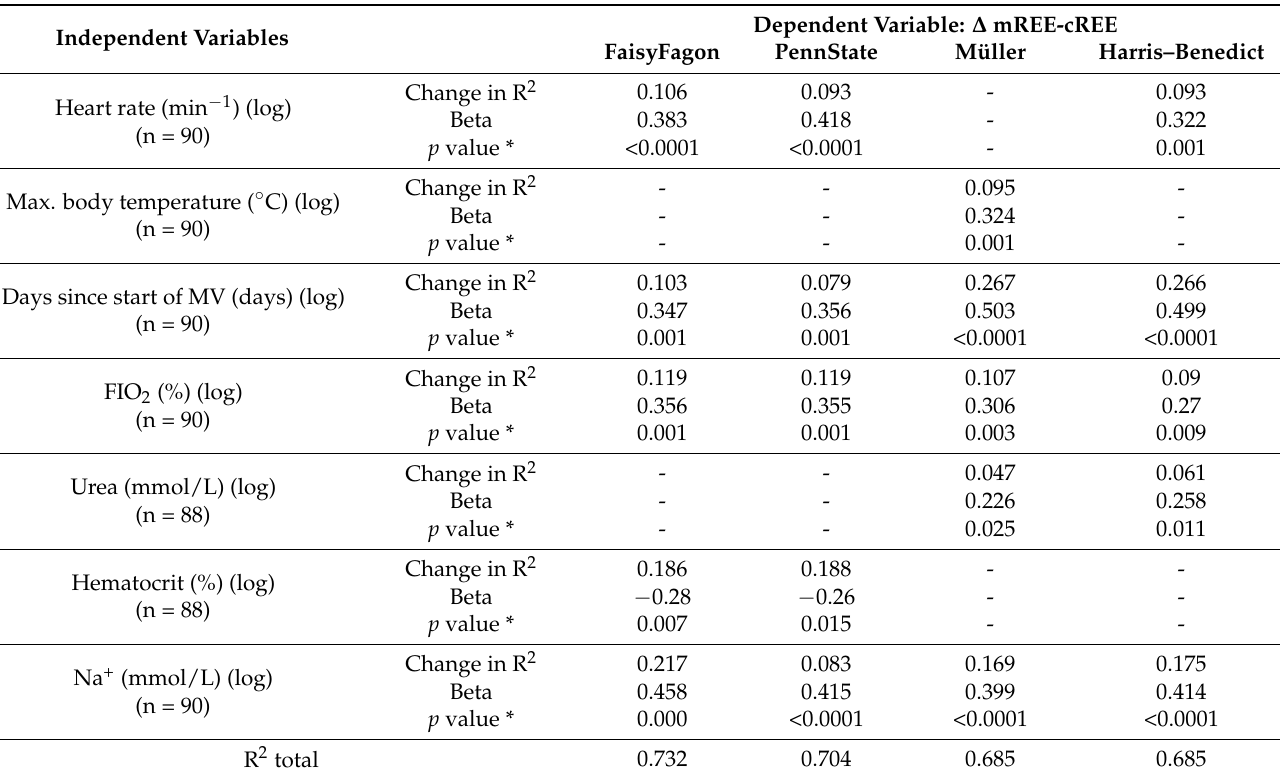
Table 3. Multivariate regression analysis for differences between mREE and cREE in the critically ill patient cohort. Abbreviations: ACCP: REE calculated from Cerra et al.; FaisyFagon: REE calculated from Faisy et al.; HarrisBenedict: REE calculated from Harris and Benedict; IretonJones: REE calculated from Ireton-Jones et al.; Müller: REE calculated from Müller et al.; FIO 2 : fraction of inspired oxygen; (log): logarithmic transformation; n: number of analyzed patients from the ICU cohort; PennState: REE calculated from Frankenfield; Mifflin: REE calculated from Mifflin et al.; REE: resting energy expenditure; *: Wilcoxon